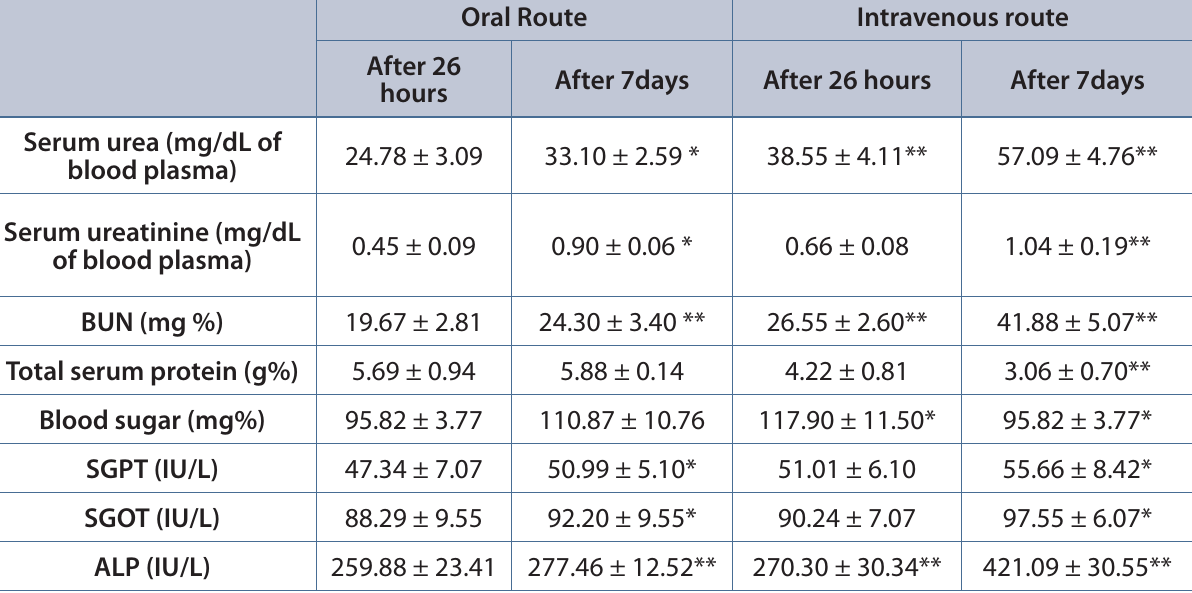
Table 4. Effect of deoxynivalenol on hepatic function after oral and intravenous administration in BALB/c